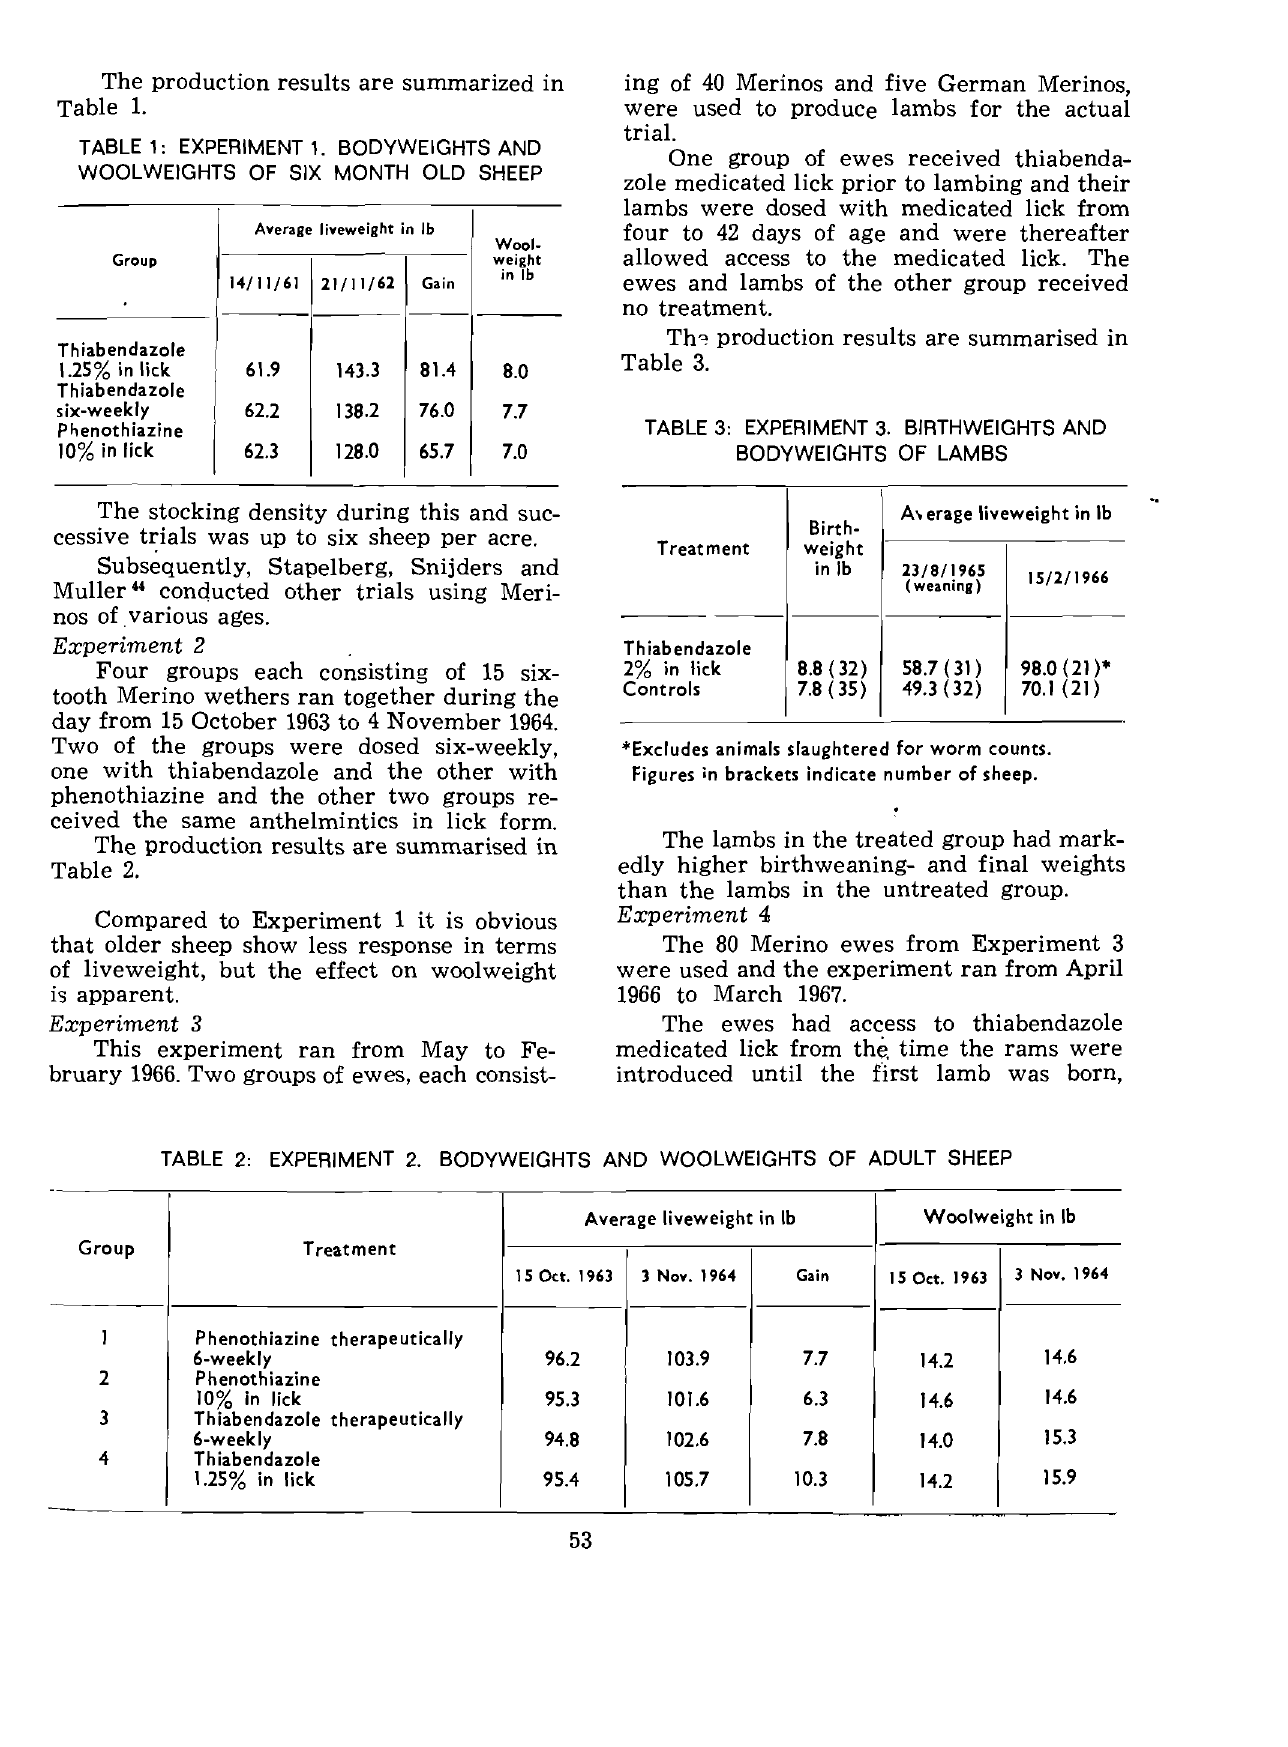
TABLE 1: EXPERIMENT 1. BODYWEIGHTS AND WOOLWEIGHTS OF SIX MONTH OLD SHEEP